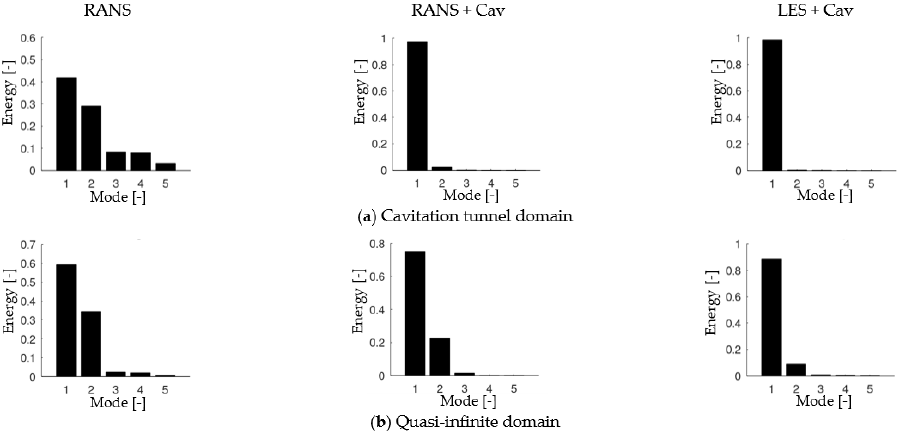
Figure 13. POD mode energies of the first 5 modes.